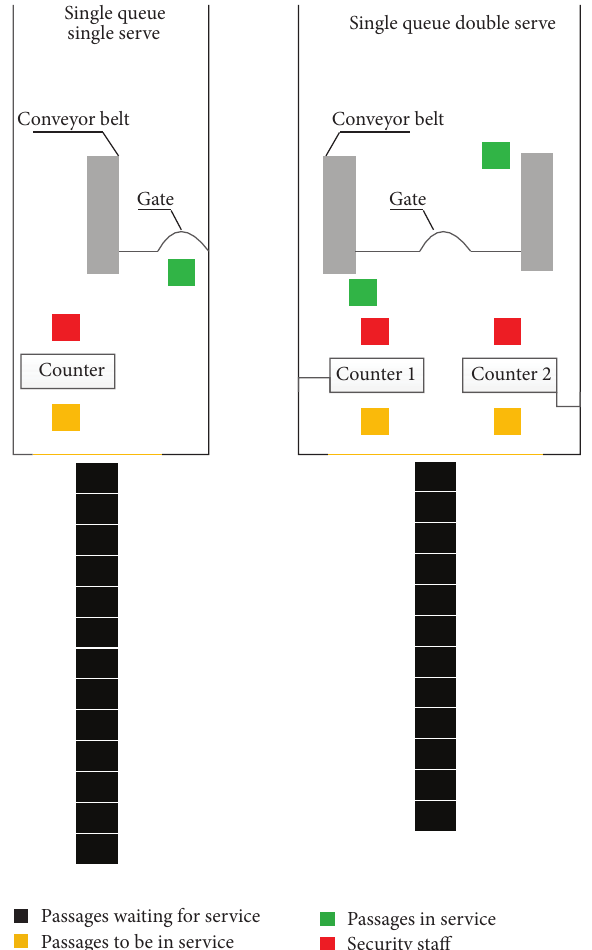
Figure9:Chartofsinglequeuesingleserve(SQSS)andsinglequeue double serve (SQDS) condition.